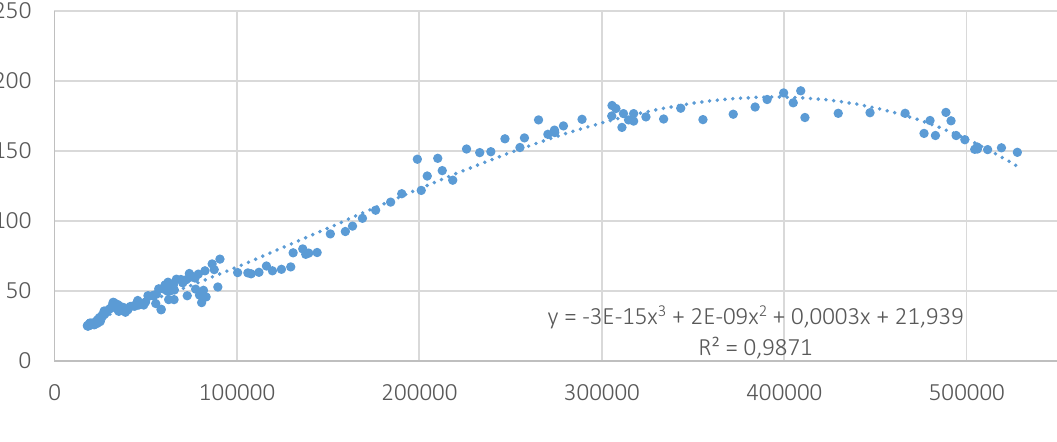
Figure 6. Energy consumption per capita in Gigajoule derived